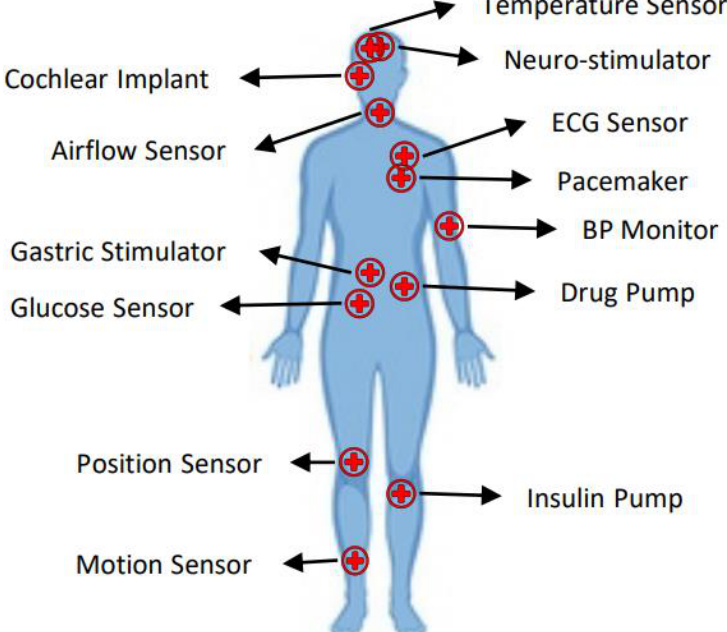
Figure 4. Implantable and Wearable IoHT Devices.